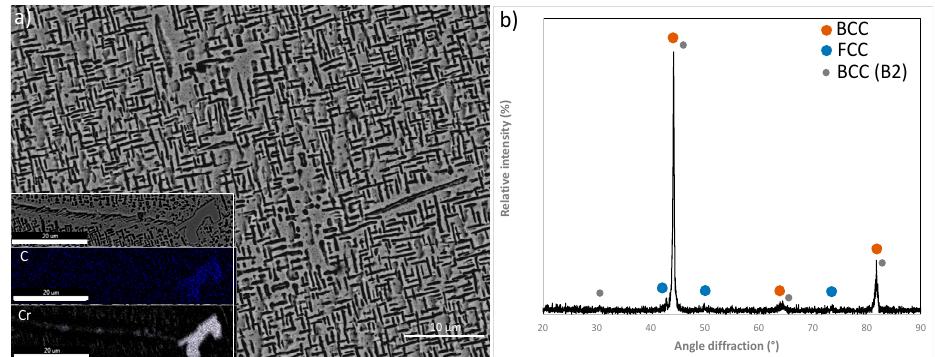
Figure 7. ( a ) Characterisation of FeCrCoNiAl 1.8 Cu 0.5 processed by P&S: microstructure, and details of C and Cr analysis on a GB. ( b ) X-ray diffractogram.